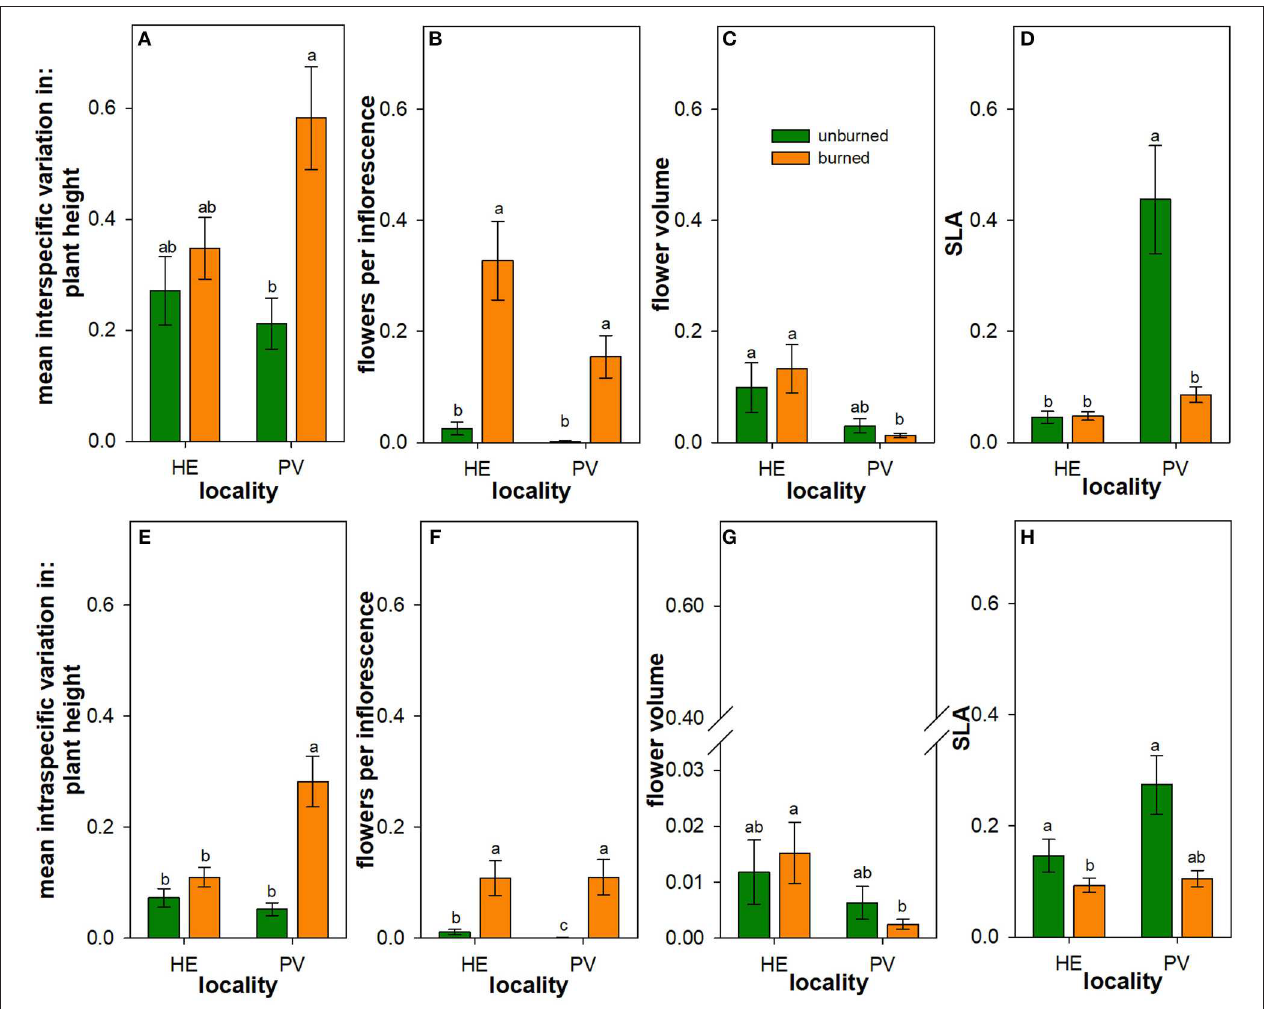
FIGURE 4 | Influence of wildfire on intraspecific and interspecific variation in plant traits. Back-transformed least square means ( ± 1SE) of the interspecific variation (A–D) and intraspecific variation (E–H) in plant height (A,E) , number of flowers per inflorescence (B,F) , flower volume (C,G) , and specific leaf area (SLA) (D,H) across all individuals of all species in burned (orange) and unburned (green) plots. Letters represent significant differences in means at α = 0.05 based on transformed values. Scaling is consistent across panels for ease of visual comparison, though note the broken y-axis in panel to accommodate the extremely low intraspecific variation in flower volume. N = 16–18 unburned plots per locality; N = 36 burned plots (mixed-severity and high-severity fires) per